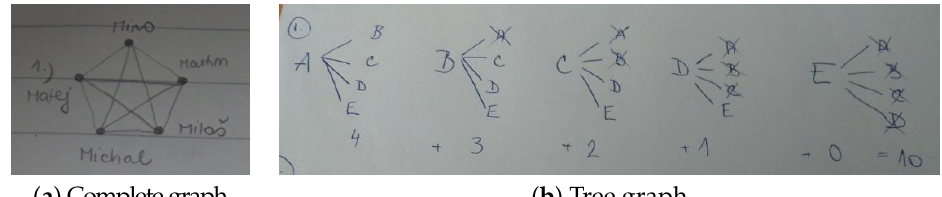
Figure 3. Different representations for the handshaking